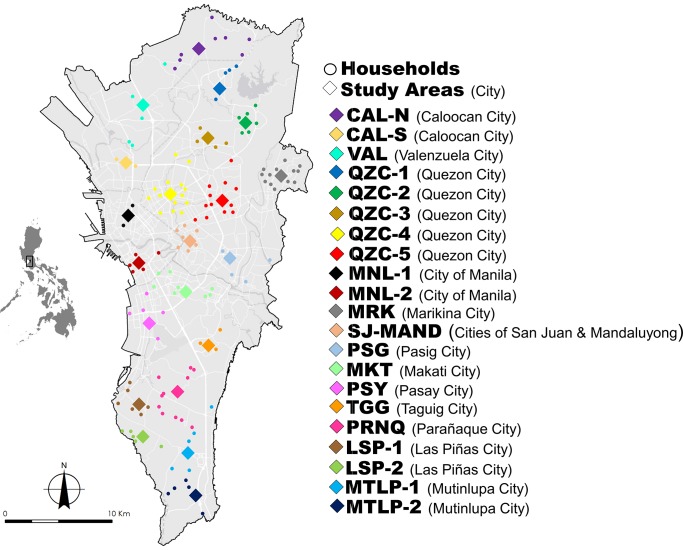
Geographic midpoints of Ae. aegypti study areas (colored diamond) with their corresponding household sites (colored circles) in Metropolitan Manila.Details of each study area can be seen in S1 Table. The map was prepared using ArcGIS version 10.2.2 from LandsatLook Viewer (http://landsatlook.usgs.gov/).